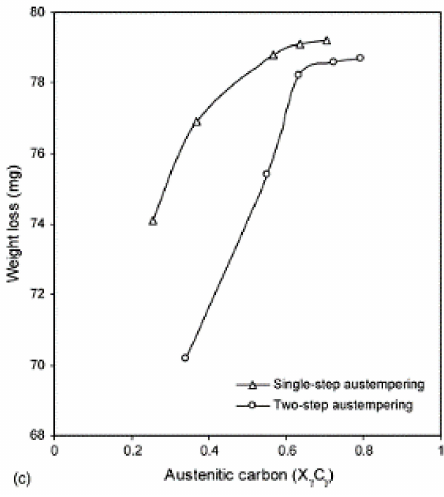
Figure 38. A graph of weight loss from wear against ADI microstructural characteristics: ( a ) austenitic volume fraction (X y ), ( b ) austenite carbon content (C y ), and ( c ) austenitic carbon (X y C y ).